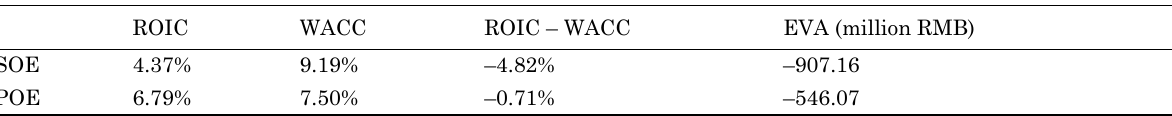
Table 8. Average POIC, WACC, ROIC – WACC and EVA of SOEs and POEs during the period